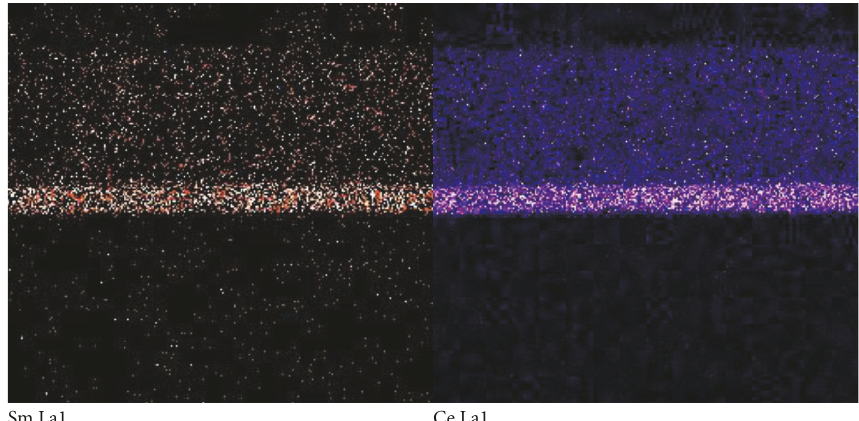
Figure 4: EDS chemical maps for Sm and Ce elements.